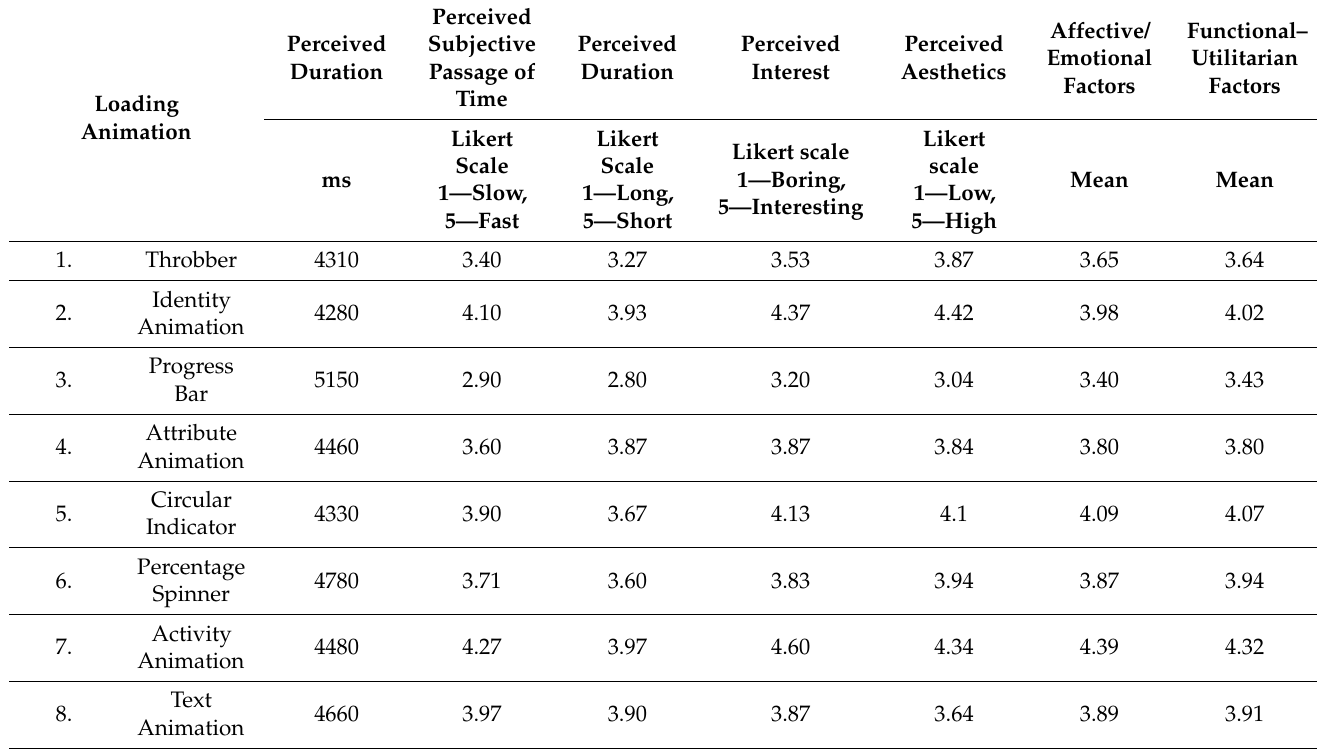
Table 2. Results of the descriptive statistics for seven QoE